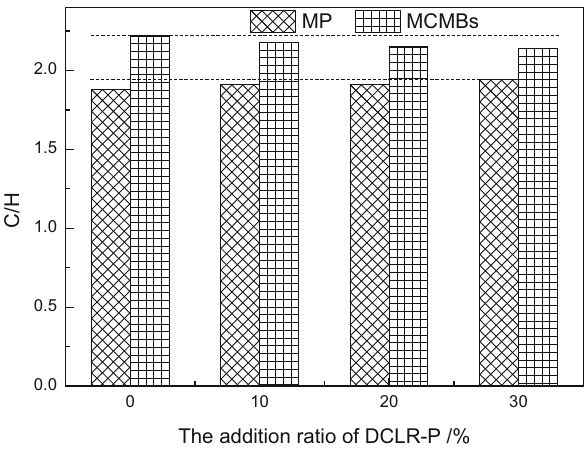
Fig. 4 The ratios of C/H of MP and MCMBs with DCLR-P added